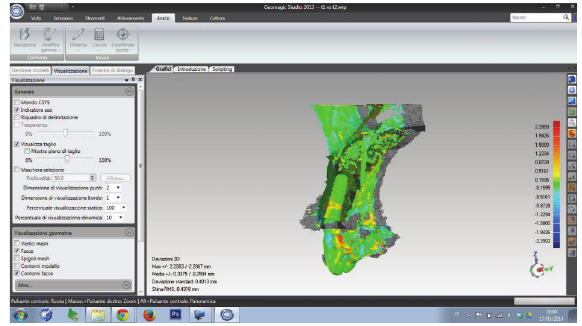
Figure 26: Overlapping of digital images, sagittal view: the stability of the regenerated bone along time was